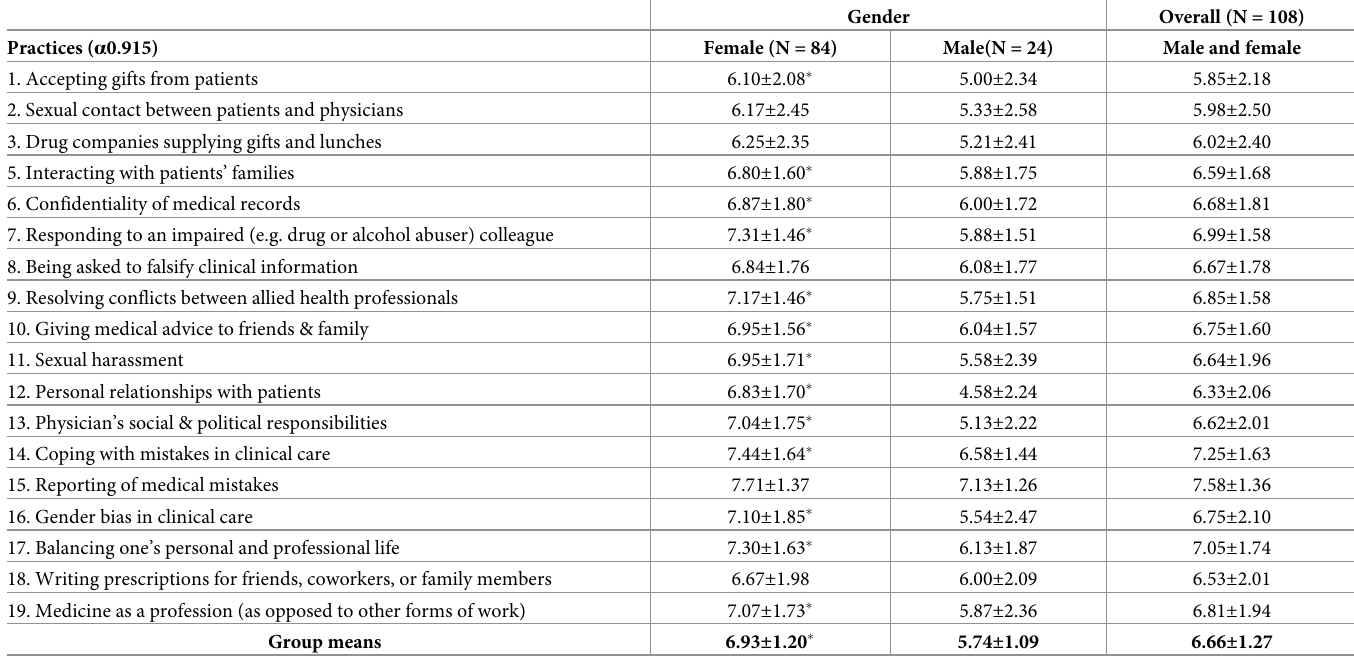
Table 2. Reported needs concerning additional training on ethically important topics pertaining to relationships and boundaries during practice (Mean ±